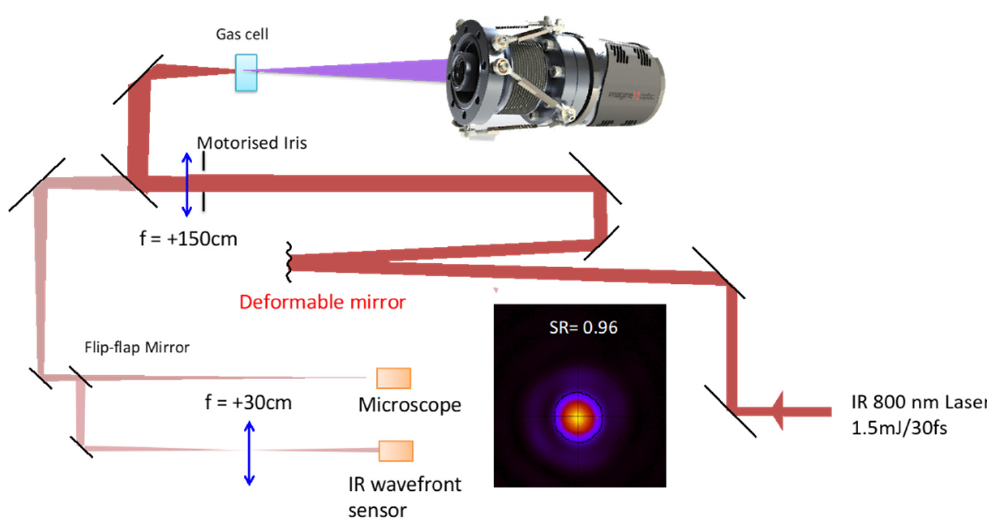
Figure 9. Schematic presentation of the experiment. The infrared laser path is displayed as the red beam while HHG is represented in purple. The picture shows an Extreme Ultra Violet (EUV) wavefront sensor manufactured by Imagine Optic. The image shows the best infrared focal spot achieved during the experiment and measured with the microscope.